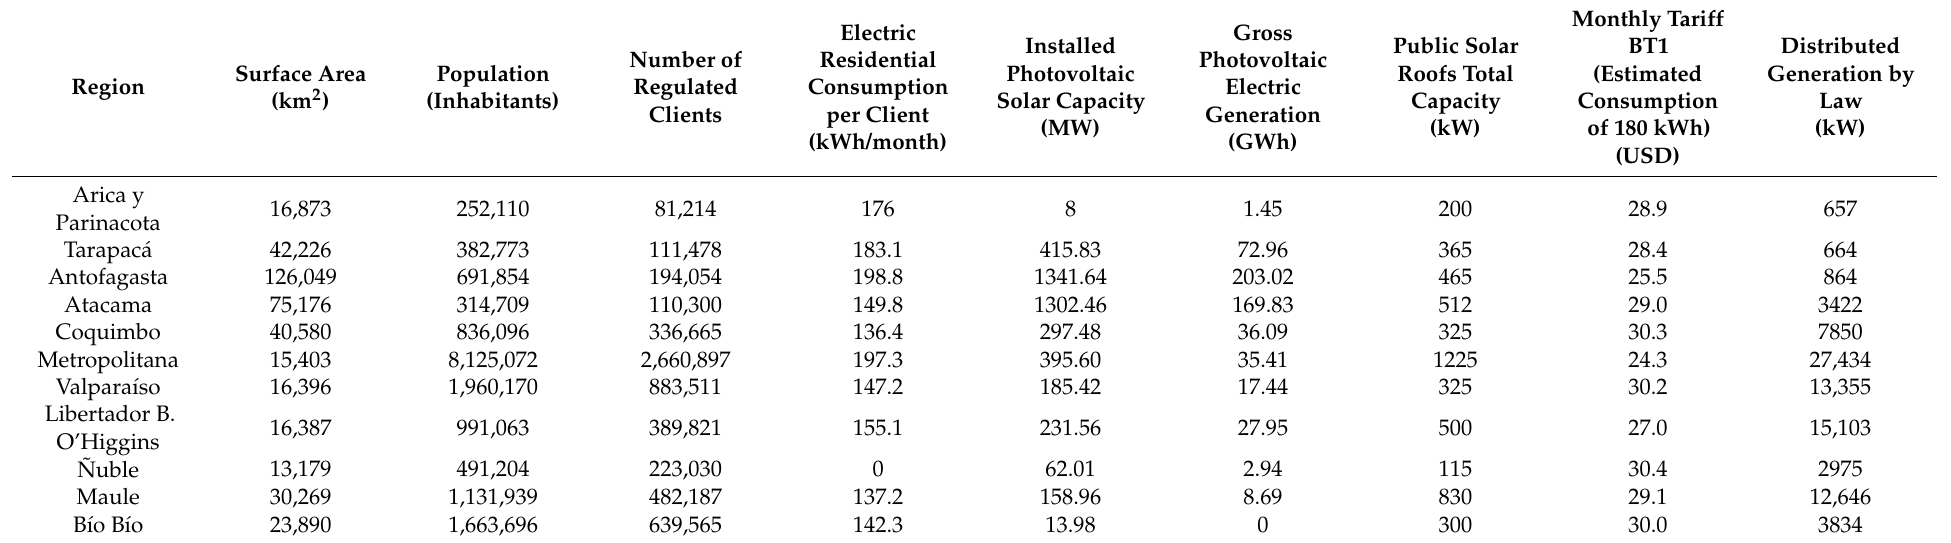
Table 2. Chilean regional statistics related to solar energy consumption, 2021